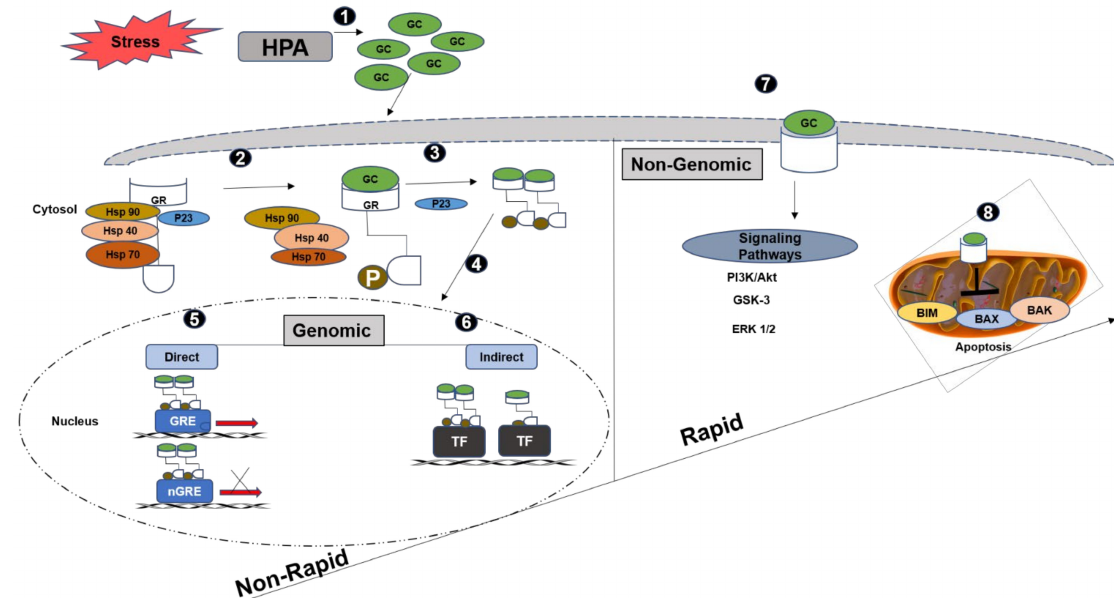
Figure 6. Genomic and non-genomic glucocorticoid signalling. Hypothalamic–pituitary–adrenal axis (HPA) releases glucocorticoids (GC) in response to stress ( 1 ). GC binding to cytosolic glucocorticoid receptor (GR) results in the dissociation of heat shock proteins (Hsp 90, Hsp 40, Hsp 70) and brings a conformational change leading to the phosphorylation and dimerisation of GR. ( 2 , 3 ). The GC-GR complex translocates into the nucleus ( 4 ), where it may result in transcriptional upregulation by direct DNA binding to positive glucocorticoid response elements (GRE) and down-regulation by binding to negative glucocorticoid response elements (nGRE) ( 5 ) or indirect DNA binding via transcriptional factors (TF) ( 6 ). The rapidly occurring non genomic mechanisms take place through the membranous glucocorticoid receptor (mGR) ( 7 ) that activate the proliferative signalling pathways, and cause inhibition of apoptosis by translocation of GR to mitochondria ( 8 ). Adapted from